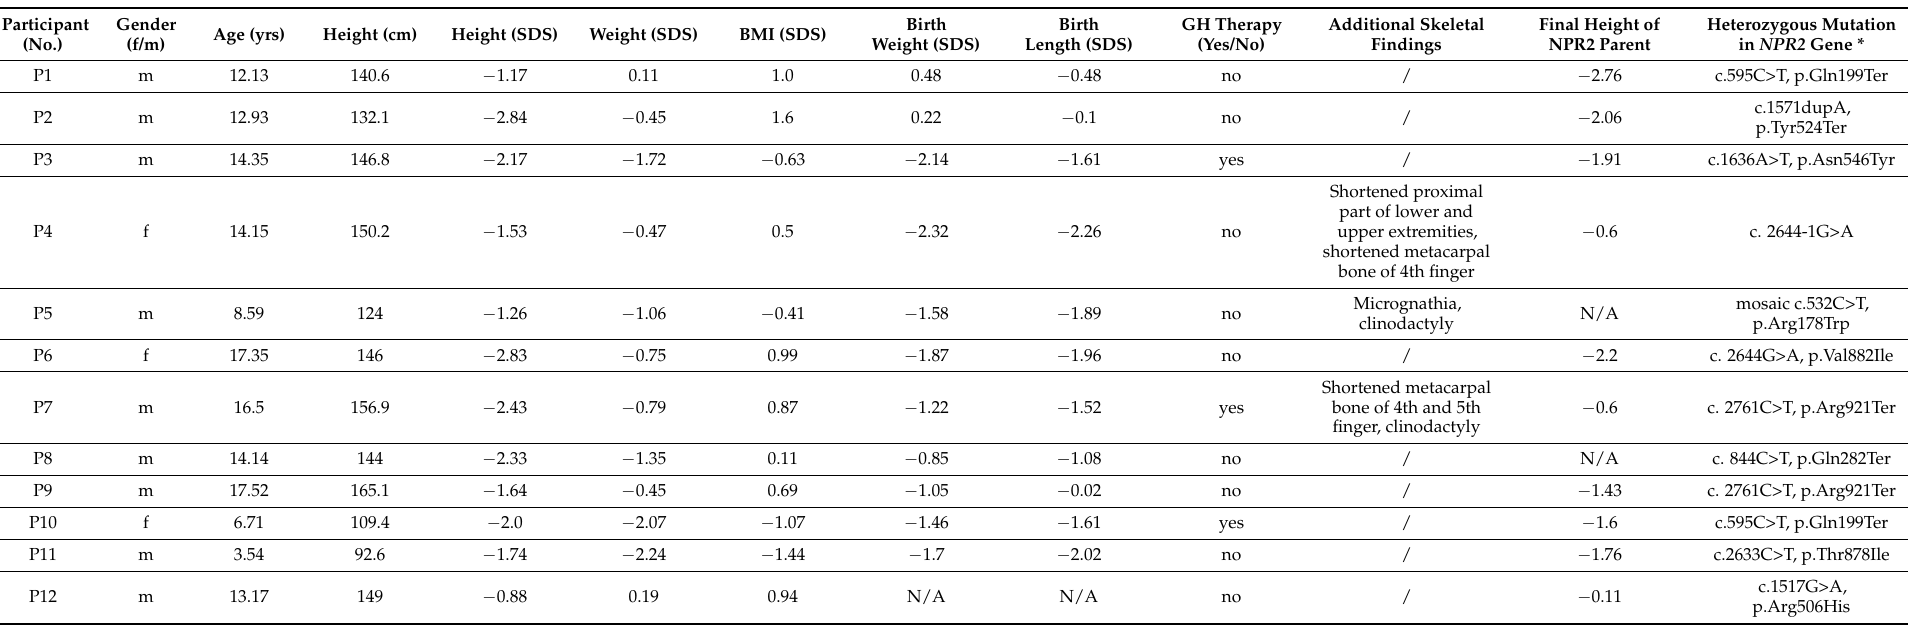
Table 1. Clinical features of study probands at current age and final height of their parent with the corresponding heterozygous NPR2 variant. f—female,